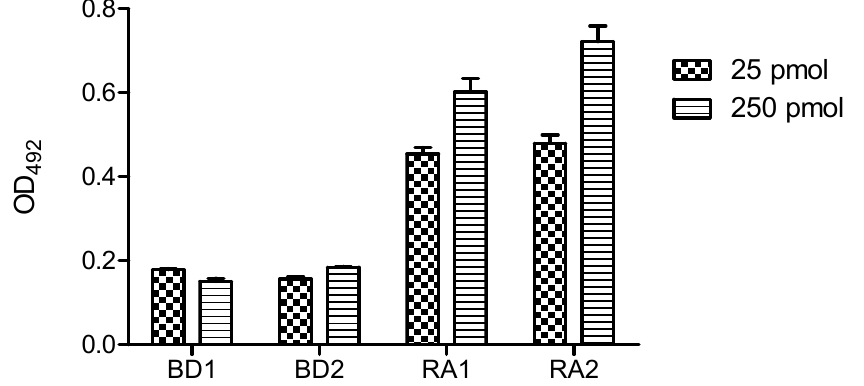
Figure 8. Reactivity of rheumatoid arthritis (RA) and blood donor (BD) sera with duplex OPC (OPC-8 with its complementary strand 5 ′ AAGAGAAAAGAATTTTT-NH Concentration of 25 and 250 pmol/well of duplex OPC-8 was immobilized via amine groups on DNA-Bind TM